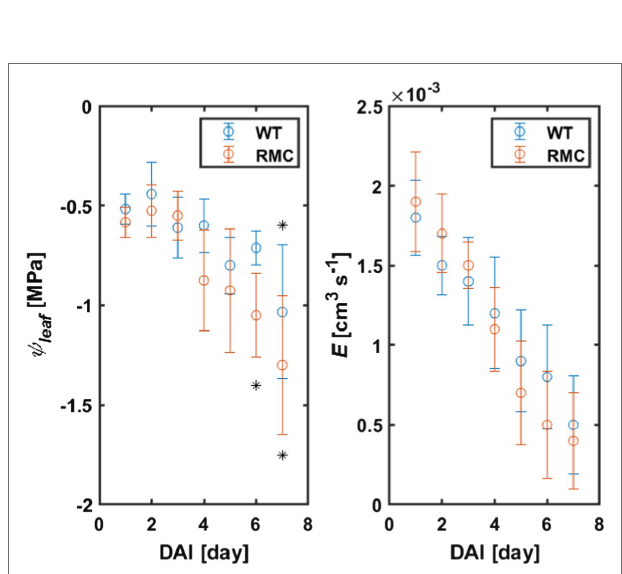
FIGURE 3 | Leaf water potential ( ψ leaf ) and transpiration rate ( E ) of RMC and WT tomato during soil drying. ψ leaf declined markedly in the absence of AMF, which nicely support our initial hypothesis. Asterisks denote significance decline of ψ leaf (value of p < 0.01), on top for WT and bottom for RMC. DAI, day after last irrigation. n =